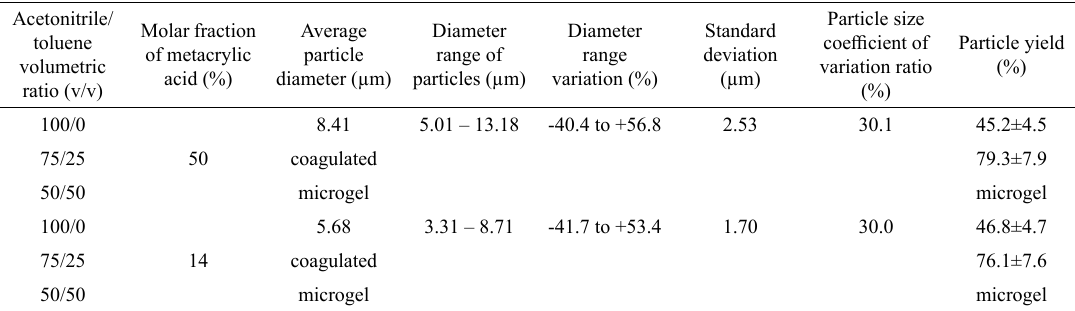
Table 6. Influence of acetonitrile/toluene volumetric ratio on the swelling ratio of particles prepared with 50% and 14% molar fraction of MMA Acetonitrile/toluene volumetric